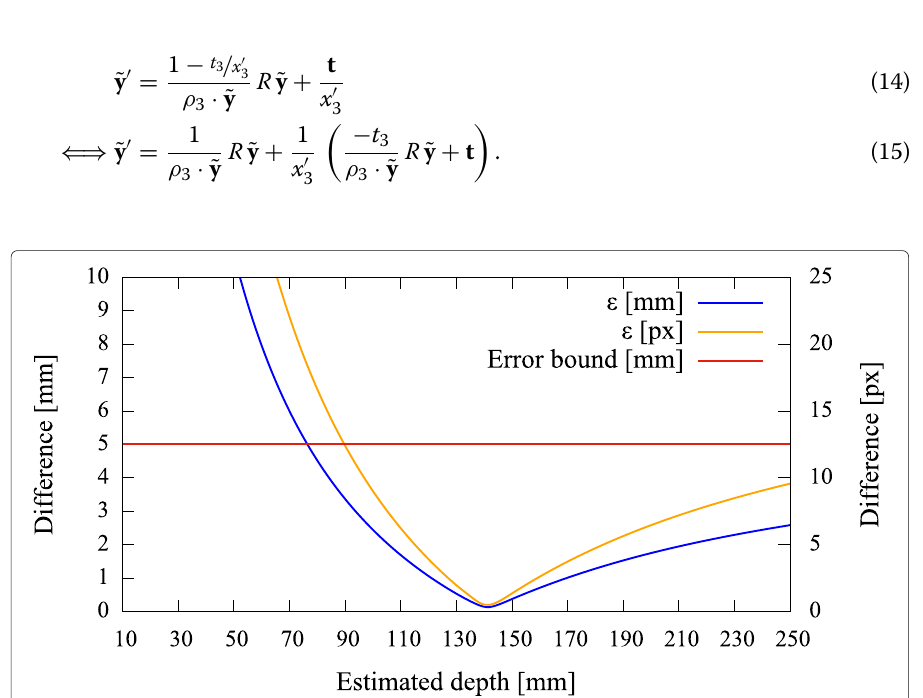
Fig. 17 Pair 4, true source distance 150 mm ( x 3 ), initial camera distance 150.3 mm ( x (cid:3) 3 ). The augmentation error is well below the acceptable error, even if the minimum error is reached at ≈ 140